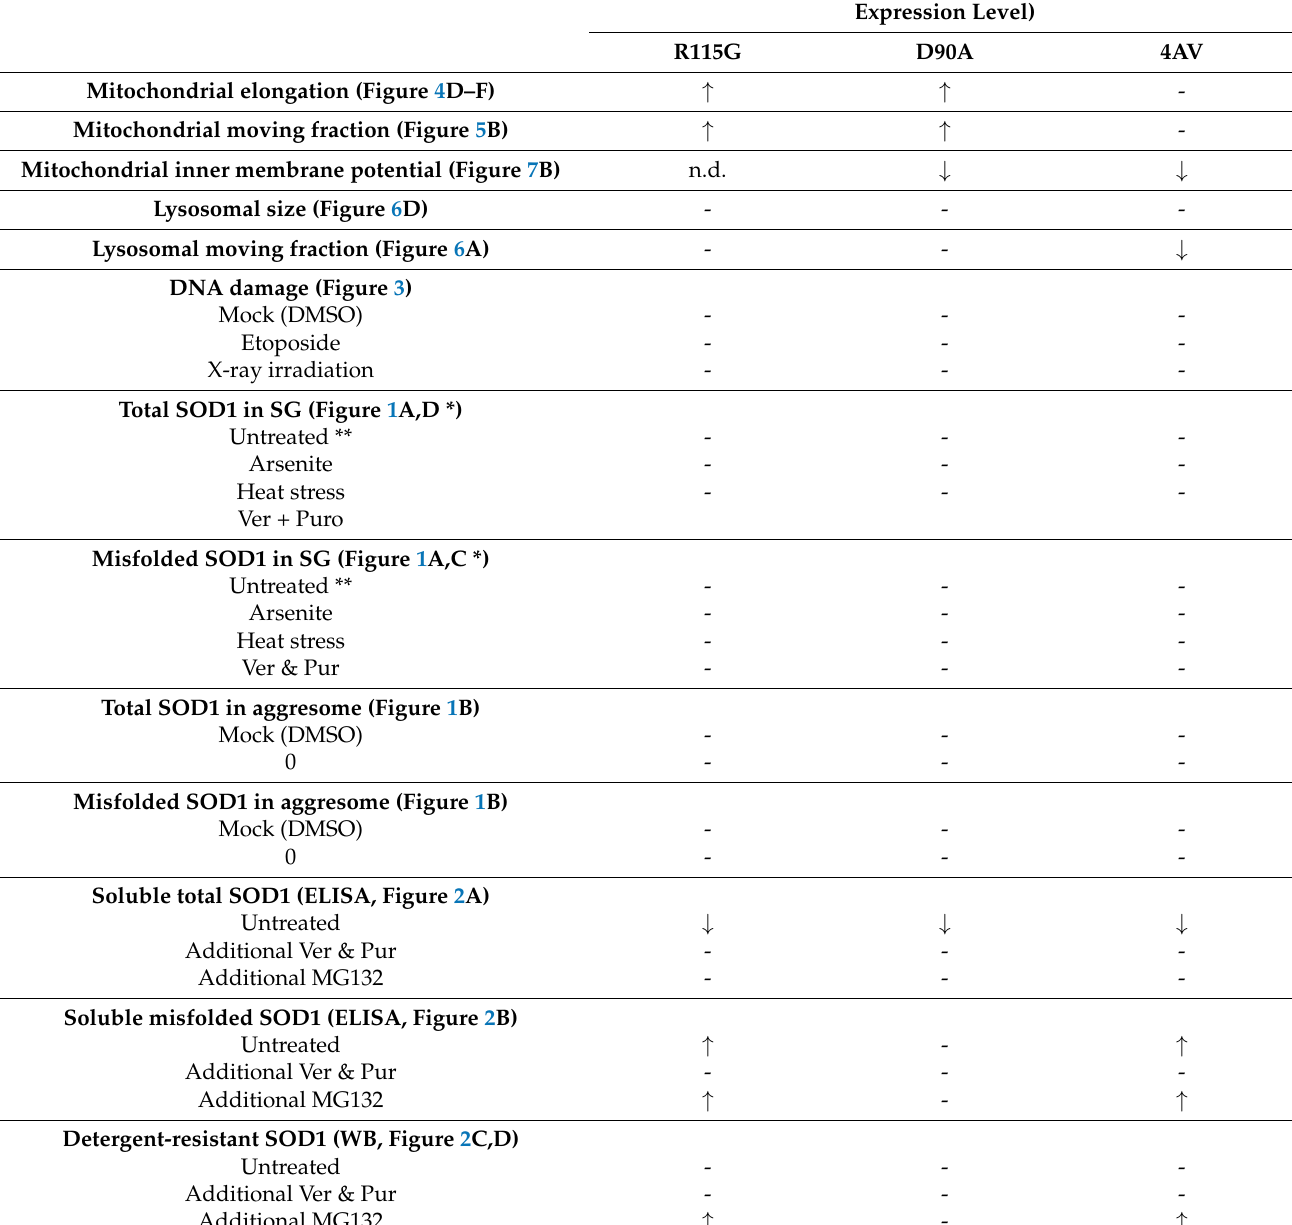
Table 2. Summary of common phenotypes. (*): Revealed by GFP-A4V-SOD1 expression, not by immunostaining. (**): No Mock control with DMSO was required here because water was serving as stock solvent for arsenite, Ver und Pur. ( ↑ ): increase, ( ↓ ): decrease. Human Spinal Motor Neurons, DIV 30 (Endogenous